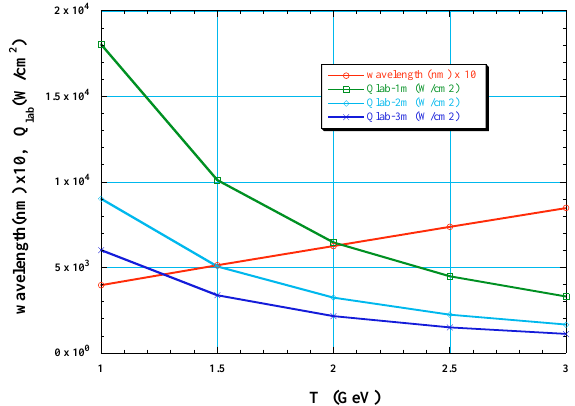
FIG. 4. (Color) Dependence of necessary laser wavelength and its power ( (cid:81) (cid:108)(cid:97)(cid:98) ) on H (cid:48) energy (cid:115) (cid:84) (cid:100)